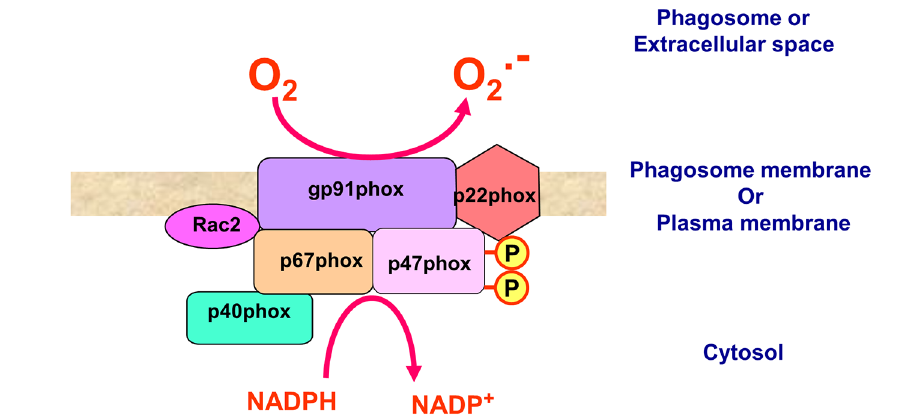
Figure 3. The NADPH oxidase complex. The active NADPH oxidase (NOX2) is composed of several cytosolic proteins (p67phox, p47phox, p40phox, rac2) and membrane-bound proteins (gp91phox and p22phox), initially referred to as cytochrome b558. The activated NADPH oxidase transfers an electron from the cytosolic NADPH to oxygen to form the radical, superoxide